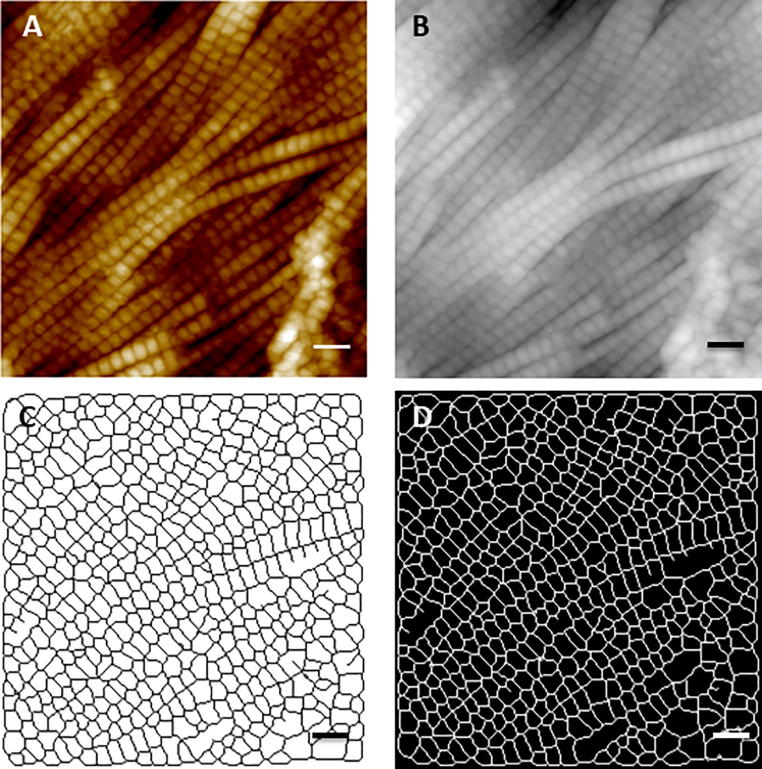
Image analysis routine: (A) Original 2 × 2 μm AFM topography image; (B) Loaded images in Image SXM; (C) Thresholded and skeletonized image; (D) Valid rectangles in the image. Scale bar represents 200 nm.